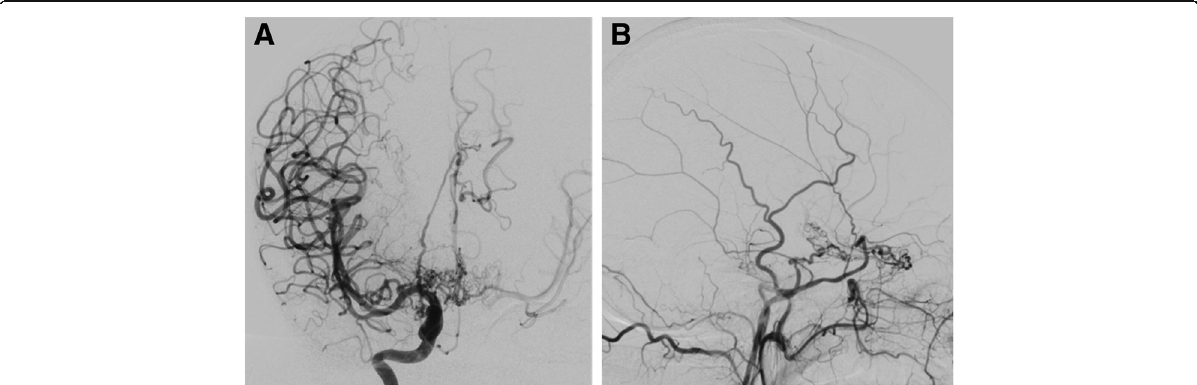
Fig. 19 Cerebral angiography in a 46-year-old Down syndrome patient with moyamoya pattern. a Frontal view, right internal carotid artery injection, showing occlusion of the right anterior cerebral artery, with a network of collateral vessels (moyamoya vessels) in the supra-sellar cistern with reconstitution of the anterior cerebral artery arterial flow distally. b Lateral view, left internal carotid artery injection, showing severe narrowing of this artery, which ends on the cavernous segment, where the arterial flow diverges to a meningohypophyseal trunk with anastomosis with the ophthalmic artery and dural branches of the middle meningeal artery, forming a network of collateral capillaries, typical of moyamoya syndrome